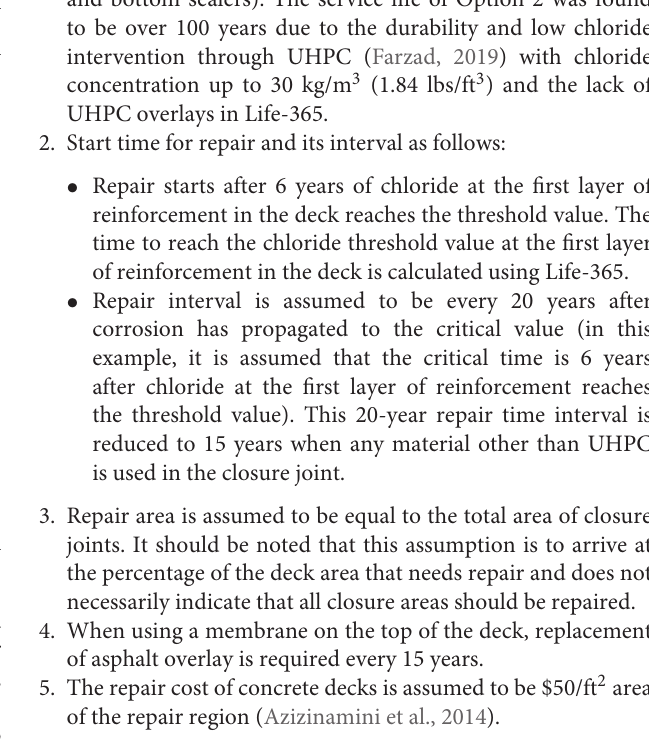
TABLE 5 | Input parameters in Life-365 for all five